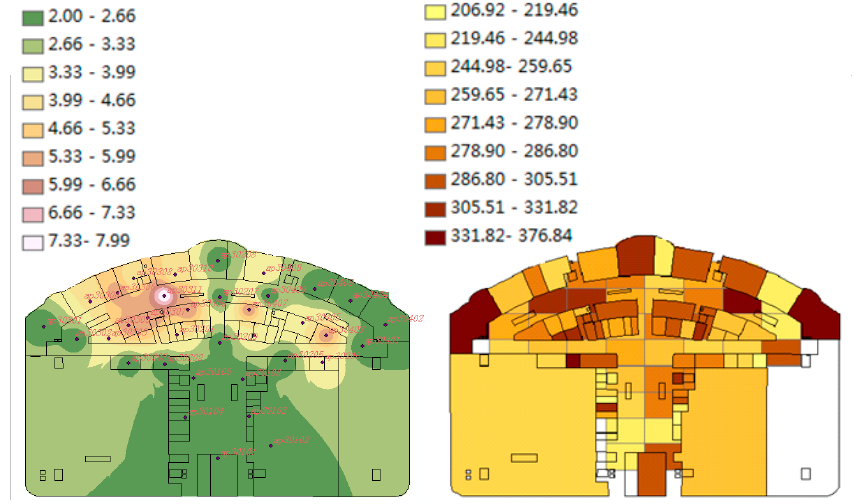
Figure 14. Comparison of the predicted and actual errors.